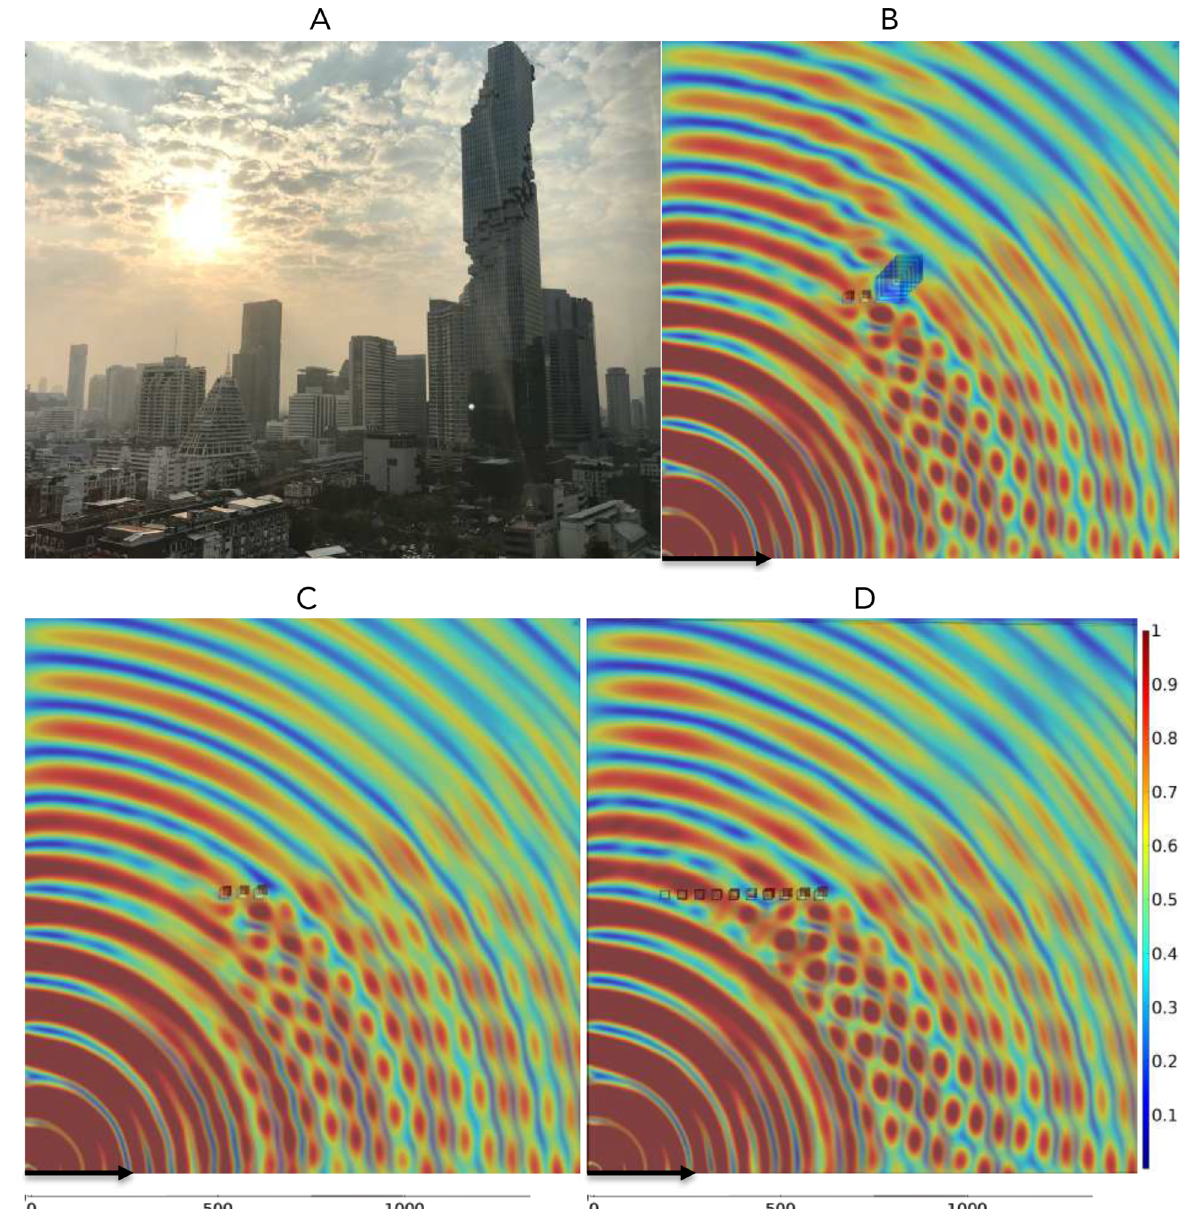
Fig. 9. Photo of a skyscraper in Bangkok (A) which stands out in the background (courtesy of B. Ungureanu). This building, modelled by a concrete pillar of height 300m and square cross section 60 m × 60m, atop a stress-free plate of thickness 40m and in fi nite extent in the horizontal plane (modelled with elastic PMLs) should interact with an incoming seismic wave at 10 Hz according to a COMSOL simulation (B), with two smaller buildings placed in front being strongly impacted by the back re fl ection from the taller one. (C) and (D) simulations show the difference of the propagation of body waves considering 3 identical buildings or 10 buildings with height varying linearly from 10 m to 100m, of square cross section 20 m × 20 m, with centre to centre spacing of 40m along the propagation path, which behave like a wave guide path. These simulations exemplify the richness of site-city